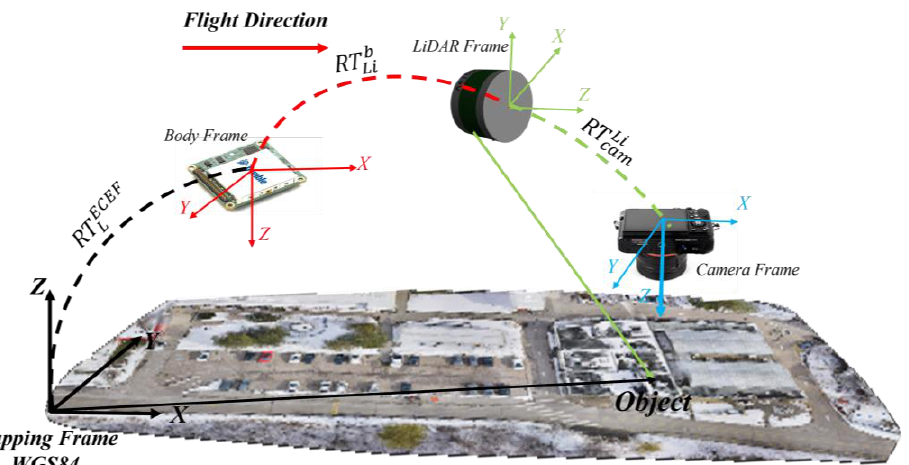
7 of 16 Figure 7. LiDAR point cloud generated using optimized LOAM SLAM algorithm [41]. 2.3. Data Synchronization All collected data were synchronized through GPS time stamp and resampled to 10 Hz to ensure correct data correspondence which is essential for subsequent processing stages. As such, the IMU data were downsampled from 200 Hz to 10 Hz for the raw accelerometers and gyroscopes measurements. Conversely, the camera pose estimations produced by Pix4D Mapper were up-sampled from approximately 0.5 Hz to 10 Hz. The resampling was accomplished using linear interpolation.